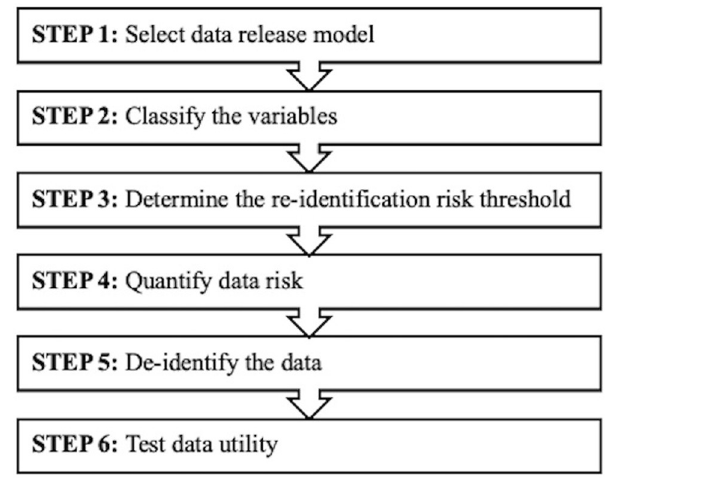
Fig 1. Six-step de-identification